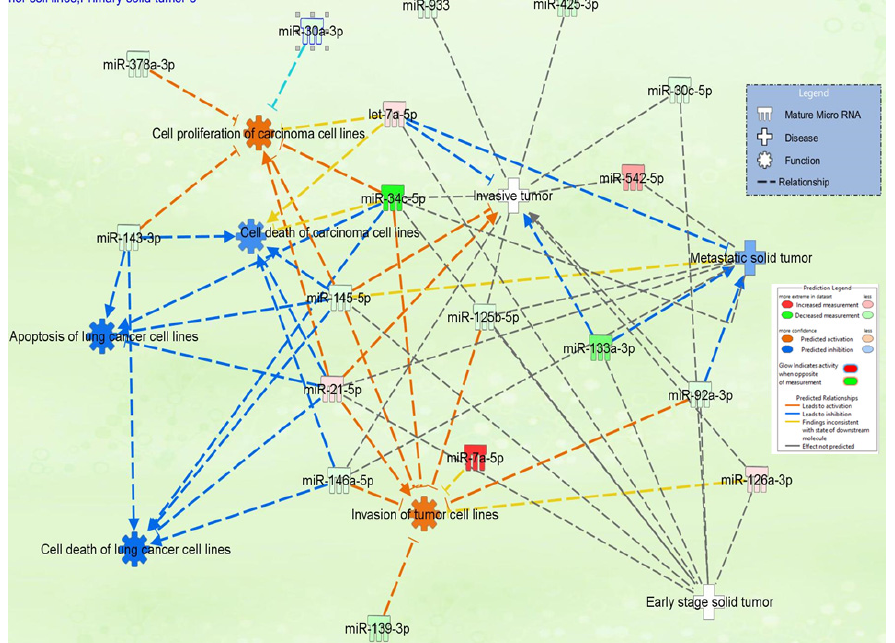
Figure 8. IPA network emphasizes the interconnection of miR-34c-5p with key cancer hallmarks, including invasion, proliferation, and metastatic potential.